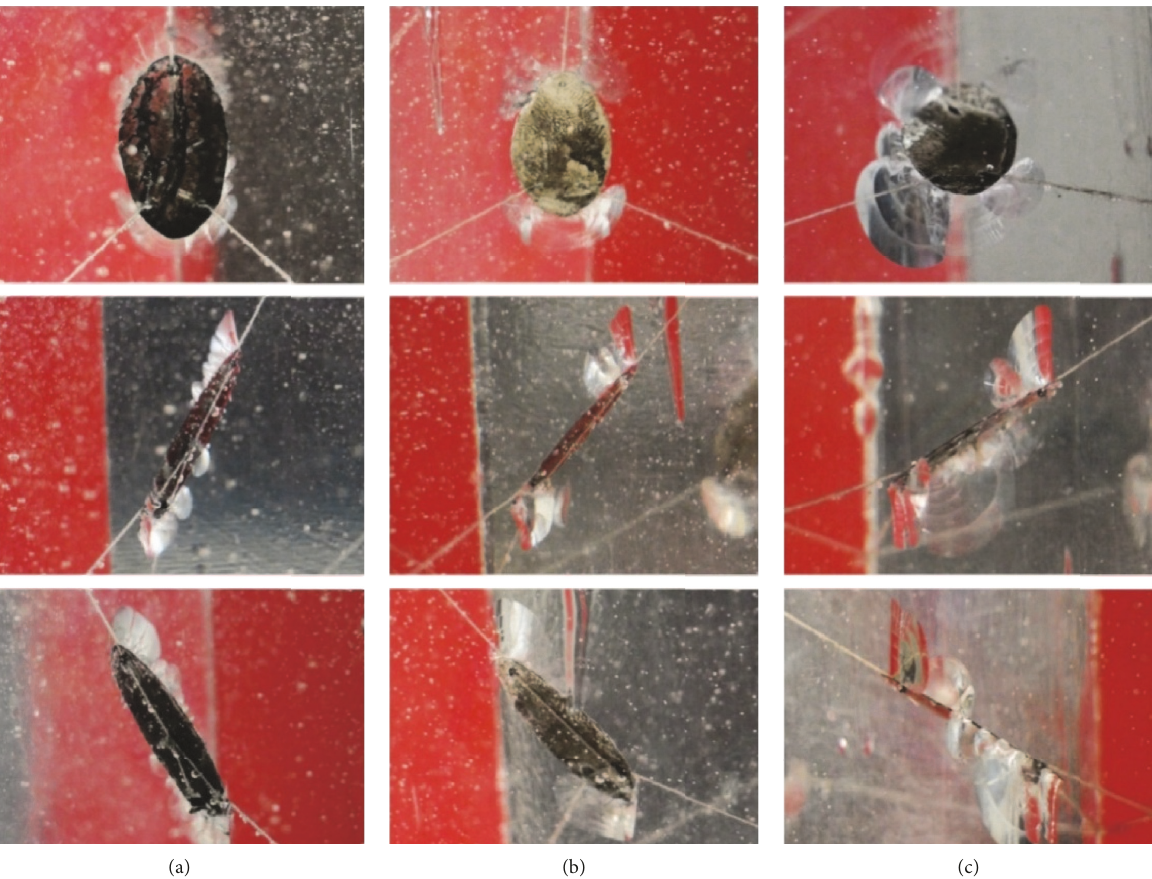
Figure 17: The 3D crack propagation result of the transparent sample at the compression loading end. (a) Specimens with 30 degree, (b) specimens with 45 degree, and (c) specimens with 60 degree.